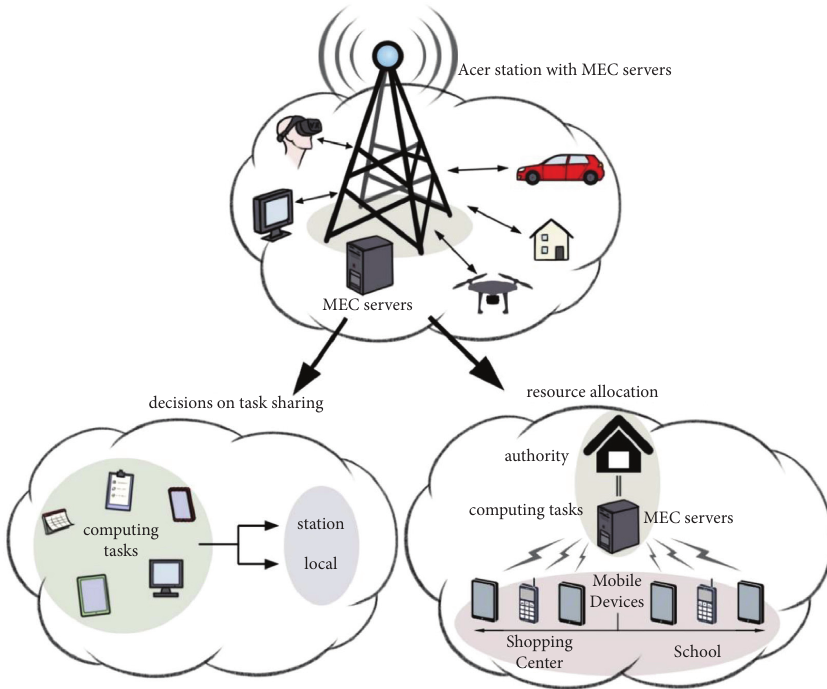
Figure 1: This diagram depicts the network model on which this paper is based. Table 1: List of all acronyms used in the paper.